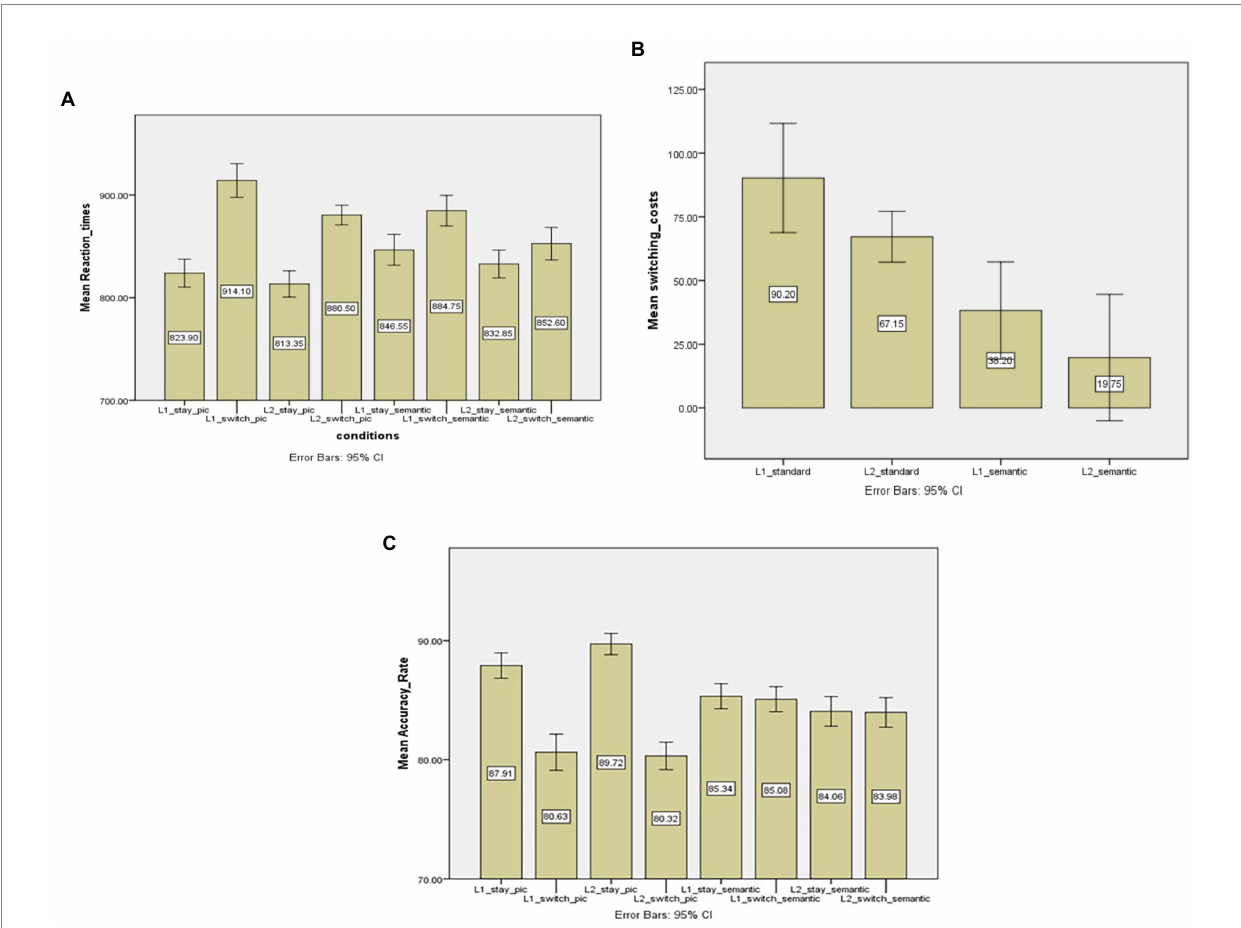
FIGURE 2 (A) Mean reaction times (in ms) of stay and switch trials across two stimulus conditions (standard vs. semantically related pictures). (B) switching costs (in ms) as a function of ‘response language’ (Chinese vs. English) and ‘stimulus type’ (standard vs. semantically related pictures). (C) Mean accuracy rates (in percentage) of stay and switch trials across two stimulus conditions (standard vs. semantically related pictures). L1 = the first language, L2 = the second language. Standard = the standard picture condition, semantic = the semantically related picture